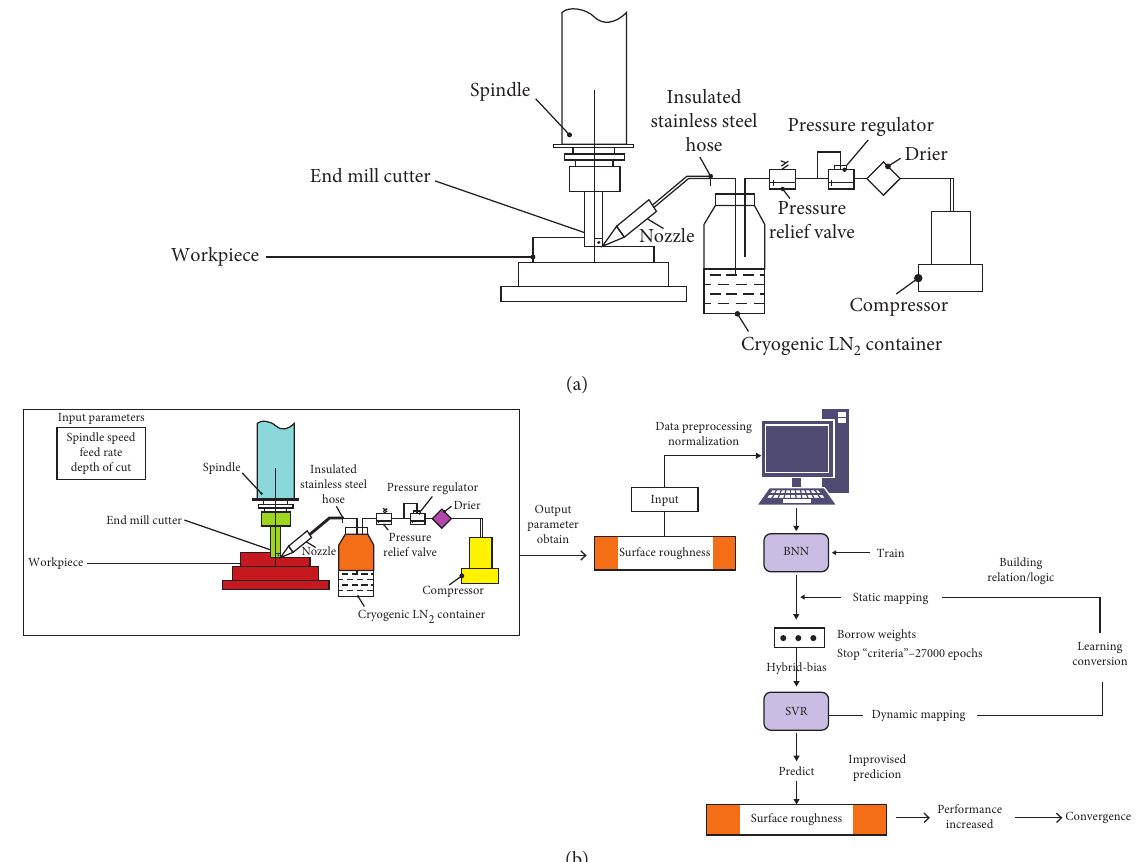
Figure 6: (a) Cryogenic schematic machining setup. (b) Flowchart of the proposed method “hybrid-bias